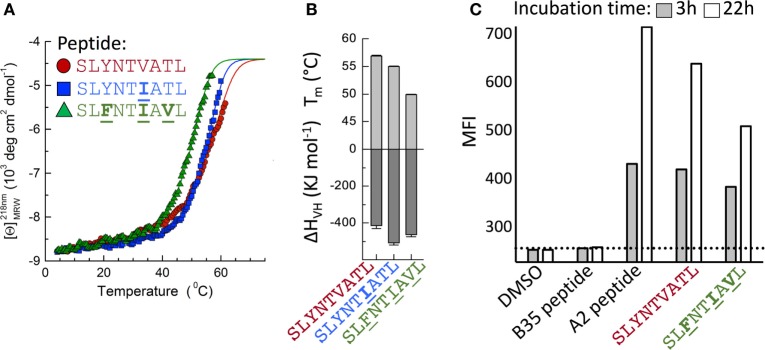
Stability of A2–SLYNTVATL, A2–SLYNTIATL, and A2–SLFNTIAVL. (A) CD thermal denaturation curves recorded at 218 nm are shown for selected samples as indicated. Dots represent measured values fitted assuming a two-state trimer-to-monomer transition (solid lines) as described in Section “Materials and Methods.” (B) Bar graphs of the thermal stability with respect to melting temperature (upper) and van’t Hoff’s enthalpy of unfolding (lower panel). Error bars in panels (A,B) represent SD resulting from the multivariable curve fitting of data from one experiment with each peptide. (C) T2 cells incubated for 3 or 22 h with 10−5 M of each peptide [Influenza (Flu) Matrix, GILGFVFTL, HIV Gag wild-type SLYNTVATL, and Gag triple mutant SLFNTIAVL] or DMSO control were stained for HLA-A2 and fixed. The dashed line is set at the mean fluorescence intensity (MFI) of the negative control peptide (EBV HPVGEADYFEY that binds HLA B*3501).